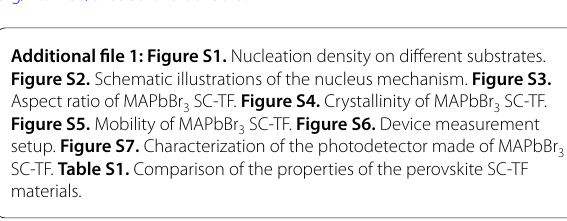
setup. Figure S7. Characterization of the photodetector made of MAPbBr 3 SC‑TF. Table S1. Comparison of the properties of the perovskite SC‑TF